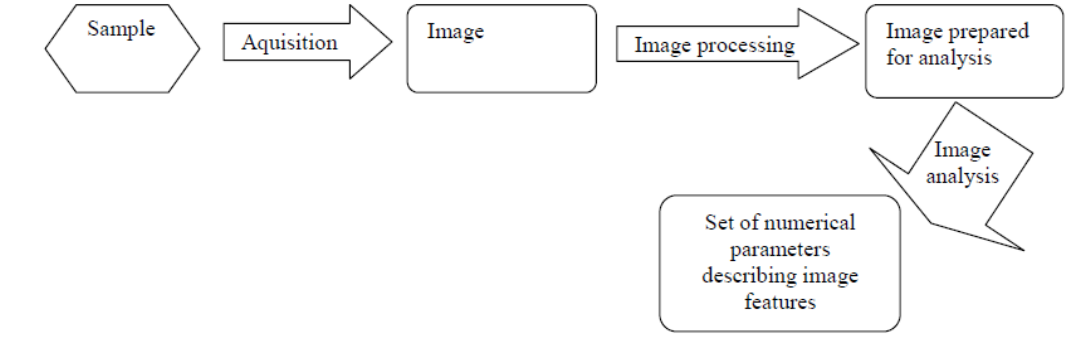
Figure 3. The scheme of the instrumental